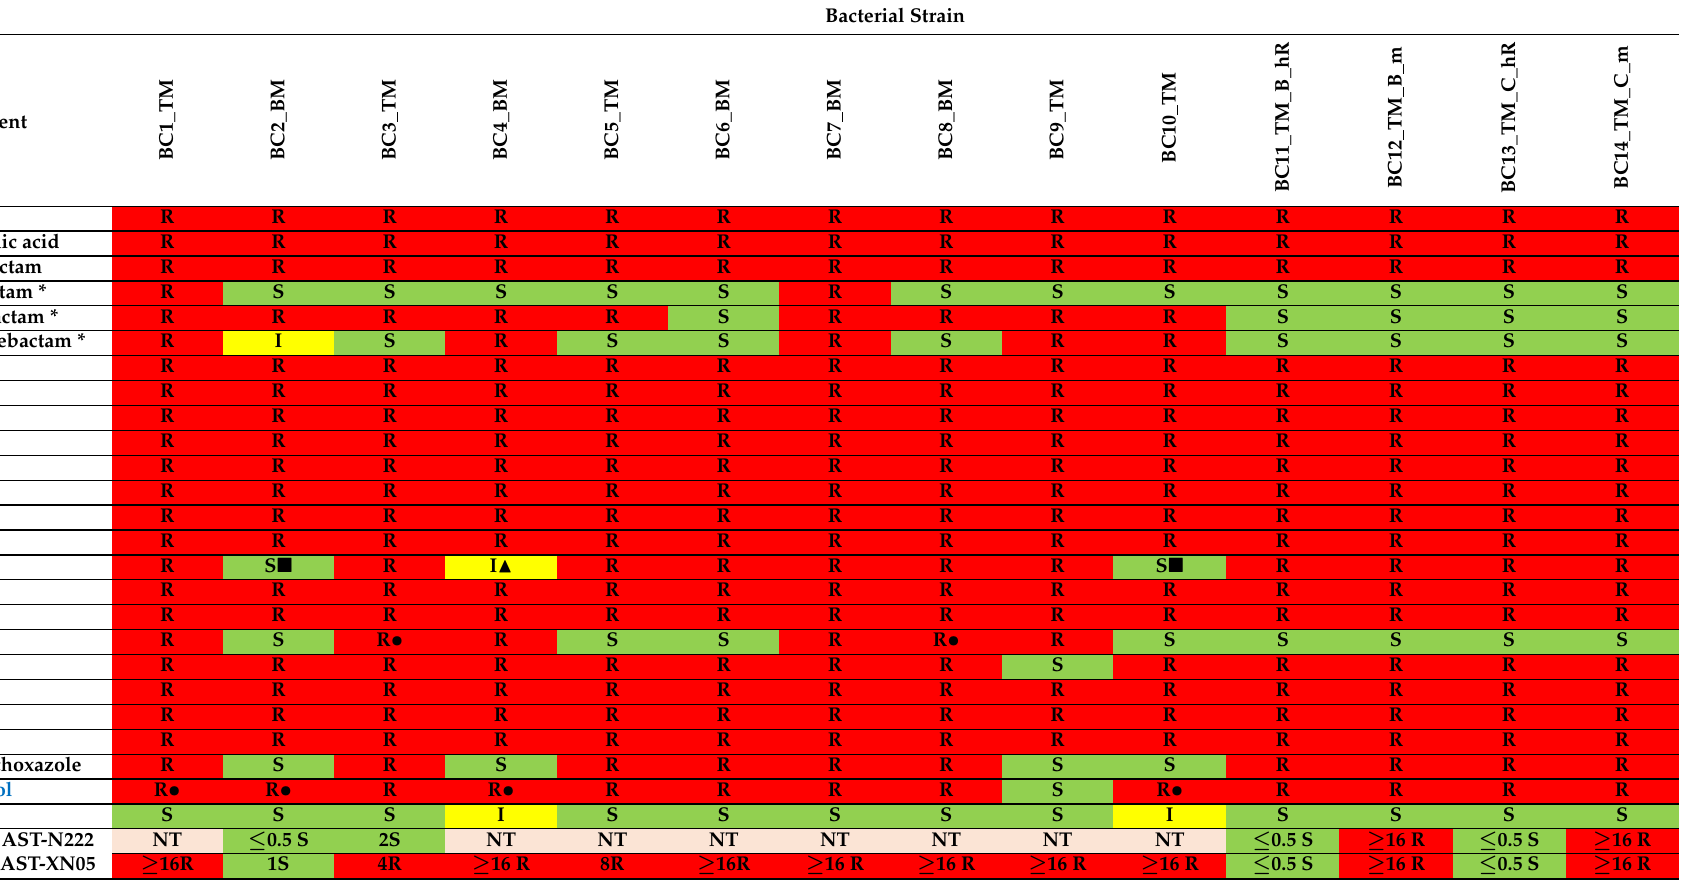
Table 1. Antimicrobial resistance profiles obtained by Vitek 2 Compact software and the disc diffusion method * for all strains.